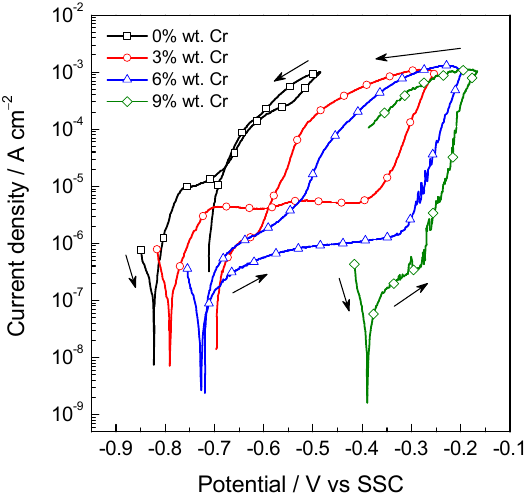
Figure 22. Cyclic polarization curves for thermo-mechanical processed (TMP) Fe-30Mn-5Al-(0,3,6,9)Cr-0.5C TWIP steels with 0, 3, 6, and 9 wt.% Cr exposed to 0.1 M NaCl solution [85]. (Reproduced with permission from refs. [85]. Copyright (2020), Elsevier).